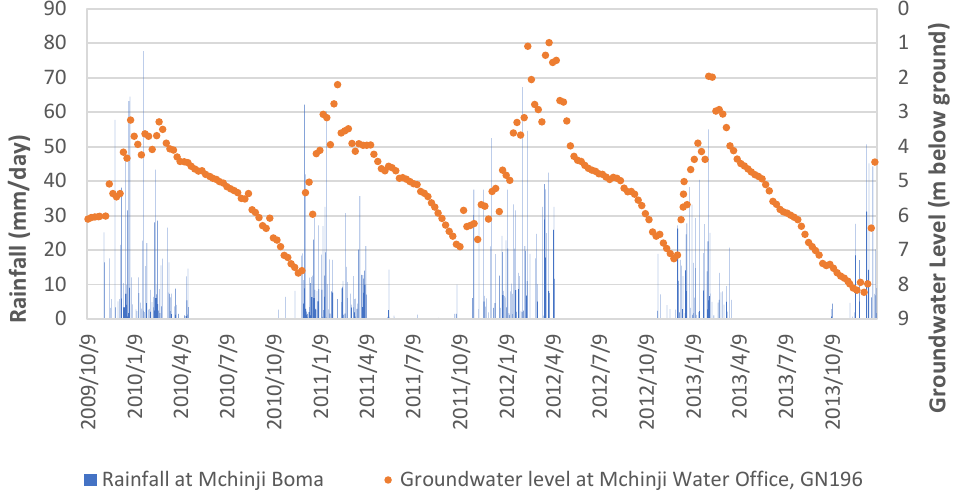
Figure 4. Daily rainfall (at Mchinji Boma) and sporadic groundwater levels (at Mchinji Water Office, GN196), located 2 km from the Bua River, Gauge 5E6, 2009 – 2013.